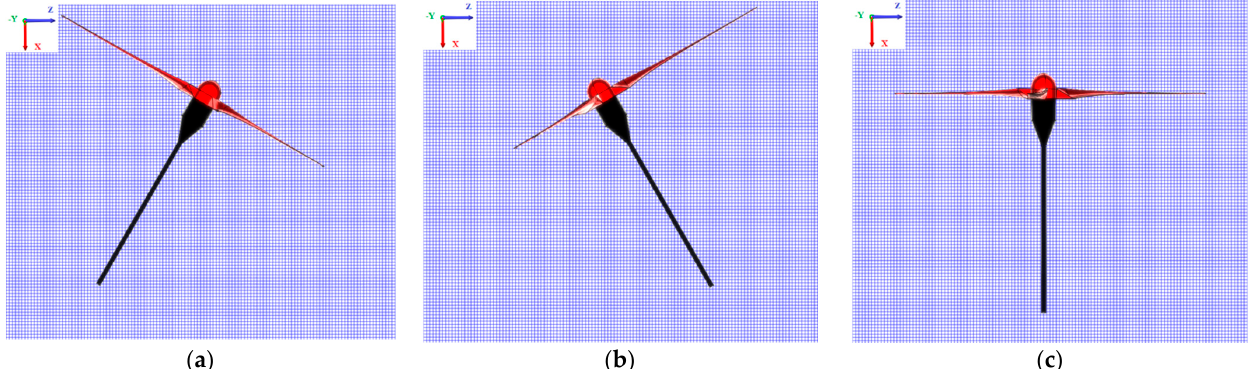
Figure 6. Lattice nodes identification in yawing process: ( a ) left yawing limit for 30°; ( b ) right yawing limit for 30°; ( c ) yawing center position.